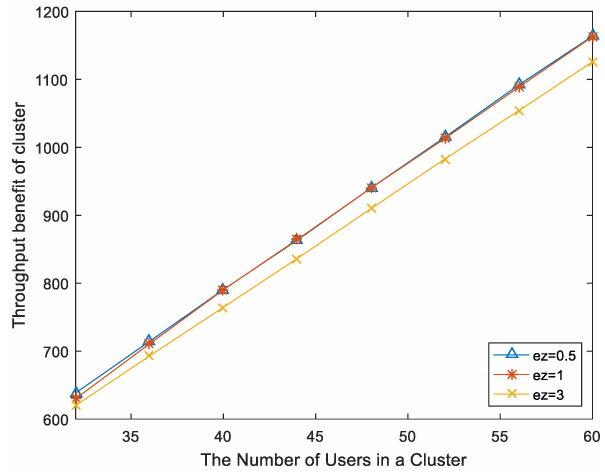
Figure 4. Throughput of cluster versus the number of user in a cluster ( K = 8, J =